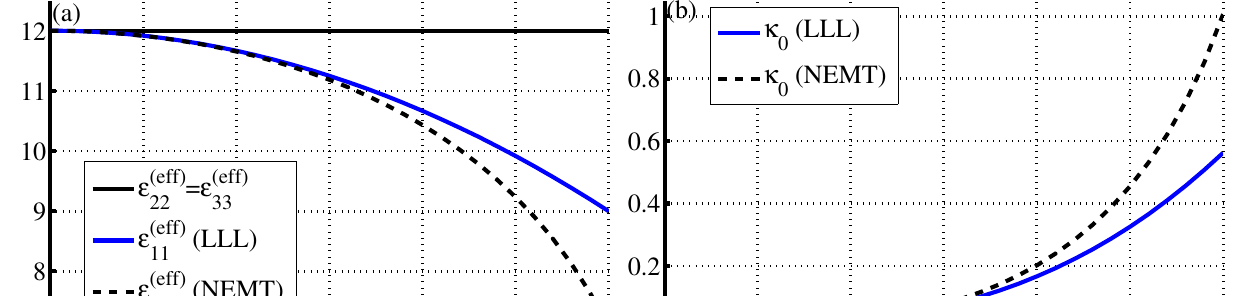
Figure 1. Comparison between effective parameters evaluated from the Landau-Lifshitz-Looyenga (LLL) approach (blue solid line) and from the non-local effective medium theory (NEMT). We have set ε = 12 , η = 0 . 1 . (a) Effective dielectric tensor components. (b) Chiral